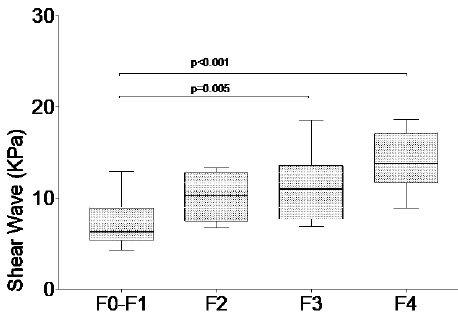
Figure 1. Shear wave elastography values in chronic HCV patients according to fibrosis stage by transient elastography. Values are shown as median and interquartile ranges.